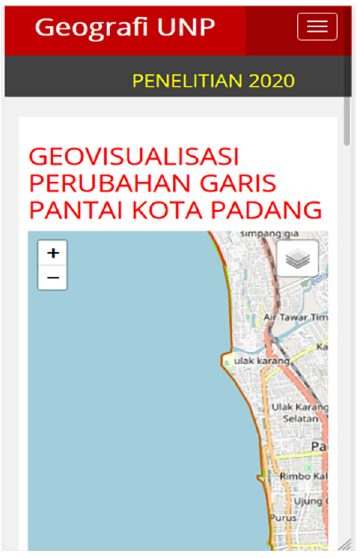
Figure 9. Trial on Iphone/android platform